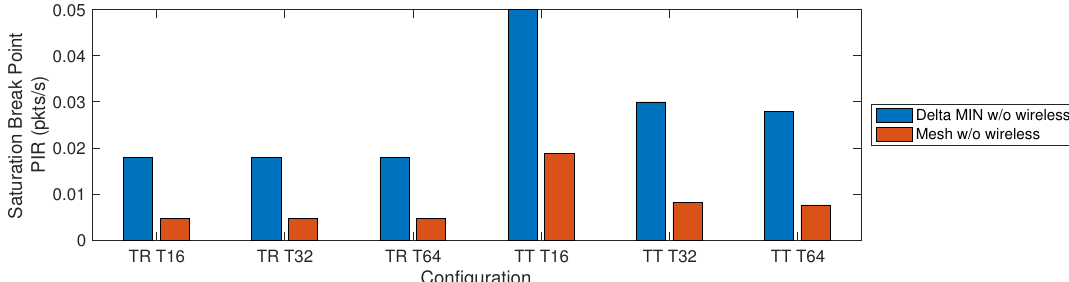
Figure 19. Saturation break point PIR (pkts/s) for Delta MIN and mesh topologies of size